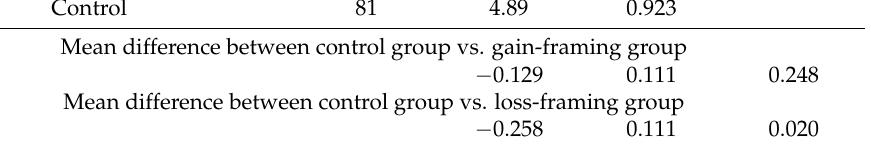
Table 2. ANOVA results for behavioral intention with means and standard deviations for message frames. N M SD Sig. Frames Gain frame 458 5.01 0.950 Loss frame 462 5.14 0.897 Control 81 4.89 0.923 Mean difference between control group vs. gain-framing group − 0.129 0.111